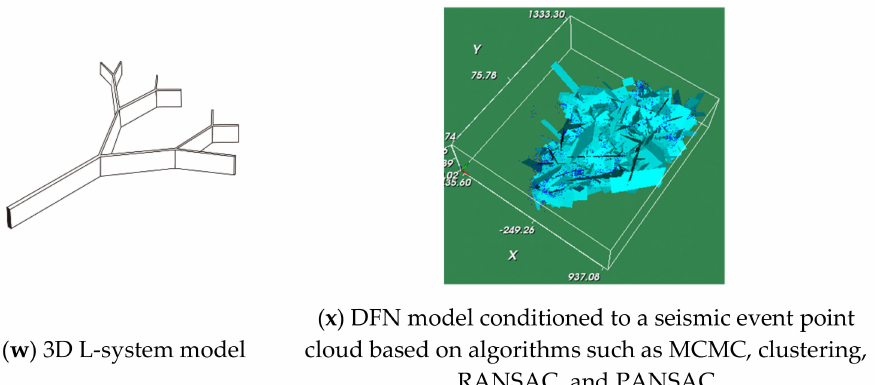
Figure 1. Schematic diagrams of stochastic fracture modelling methods [21,29,32–34,36,39–41,43,45–49]. ( a – e ) fracture modelling based on spatial subdivision, ( f – s ) discrete fracture network modelling, ( t ) fracture modelling based on geostatistics, ( u ) fracture modelling based on multi-point statis- tics, ( v , w ) fracture modelling based on iteration of fractal characteristics, ( x ) fracture modelling conditioned to a seismic event point